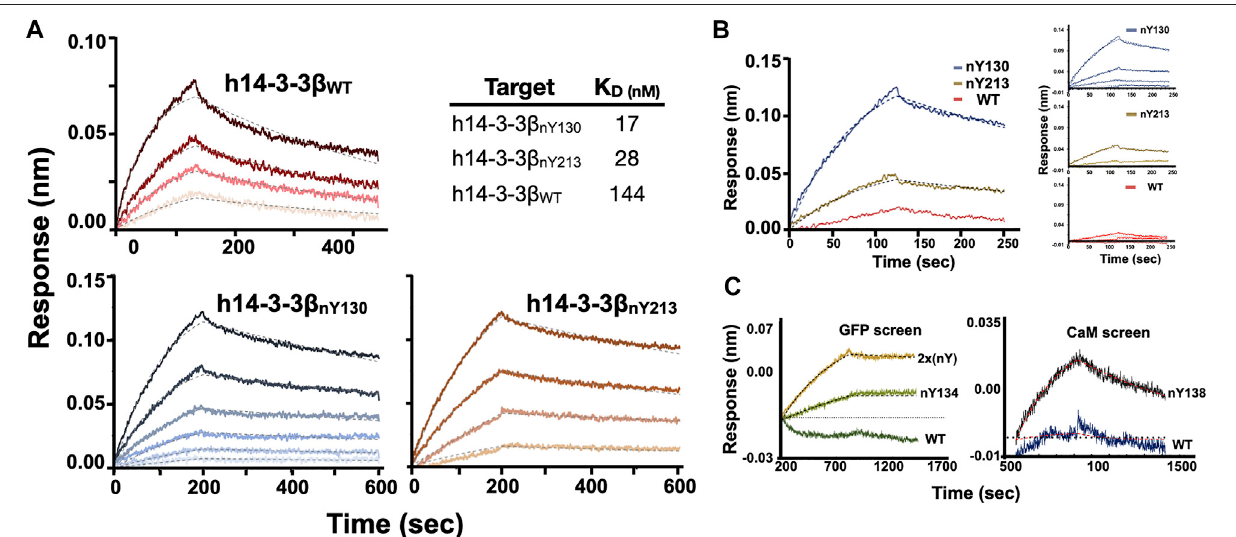
FIGURE3| BLIanalysisofNb-G5bindingability. (A) BLIsensogramsofNb-G5againstnitratedandWT14-3-3 β in0.2%BSA.Forglobal fi ts,concentrationsofNb- G5 against nitrated ranged from 25 to 200 nM for 14-3-3 β nY130 , 40 – 200 nM for 14-3-3 β nY213 and 270 – 900 nM for 14-3-3 β WT . K D values for global fi ts are listed in the upperright. (B) BLIsensogramsofNb-G5againstnitratedandWT14-3-3 β in1%BSA.Leftpanel:thesensogramsforallthreetargetsat450 nM.Rightpanel:Global fi ts forNb-G5in1%BSArangingfrom80to450 nM. (C) Leftpanel:Local fi tsofNb-G5(200 nM)againstsfGFP WT ,sfGFP nY134 ,andsfGFP 2xnY .Rightpanel:Local fi tsof Nb-G5 (300 nM) against CaM WT and CaM nY138 .